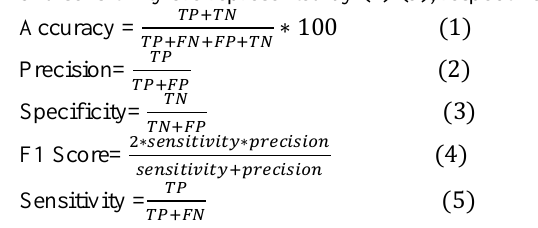
Figure 4. Resnet50 Skip connections